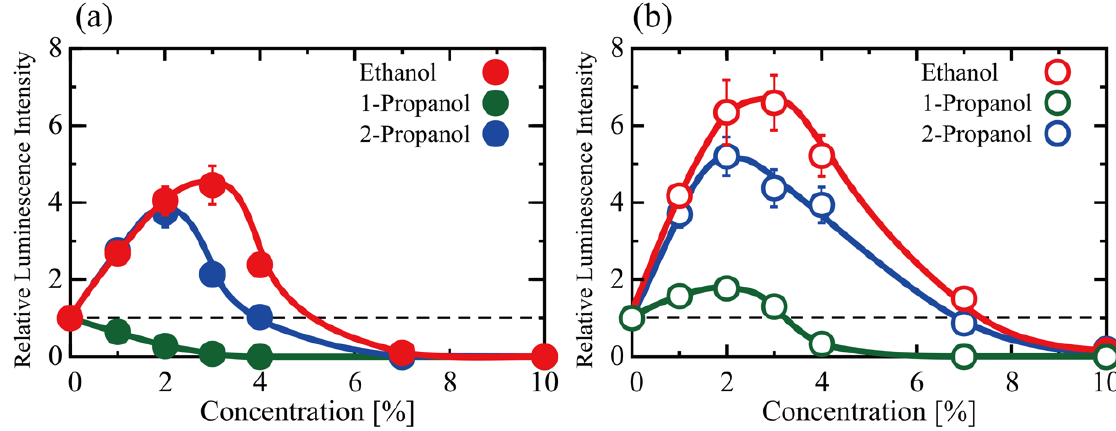
Figure 1. The effect of ethanol, 1-propanol, and 2-propanol on gene expression, ( a ) transcription- translation (TX-TL) and ( b ) translation (TL). The vertical axis shows the relative luminescence intensity of the luciferin-luciferase reaction, which corresponds to the efficiency of luciferase production. Luminescence was measured after 90 min of incubation at 30 °C. The intensity was normalized to the control (i.e., no alcohol in the reaction mixture). The concentration of DNA (Luciferase T7 Control DNA) in ( a ) and the concentration of mRNA (Luciferase Control RNA) in ( b ) was 0.3 μM. Data presented as mean ± SEM.